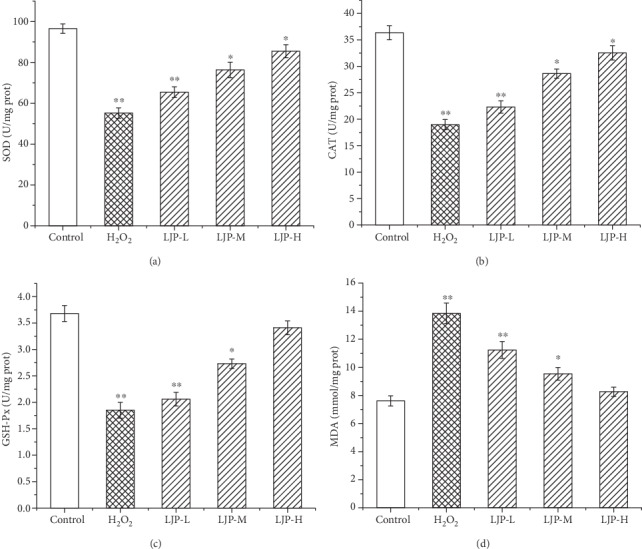
Effect of LJP on the activities of SOD, CAT, GSH-Px, and MDA in cardiomyocytes injured by H2O2. (a) SOD activity, (b) CAT activity, (c) GSH-Px activity, (d) MDA content. Cardiomyocytes were incubated with different concentrations of LJP (10, 20, and 40 μg mL−1) for 12 h. Control group was added 100 μL DMEM medium. H2O2 model group was added H2O2 (200 μmol L-1) 100 μL. Then, the activities of SOD, CAT, GSH-Px, and MDA were determined. The results are expressed as mean ± SD (n = 10). Statistical significance was determined by One-Way Analysis (ANOVA). ∗P < 0.05, ∗∗P < 0.01 versus control groups.